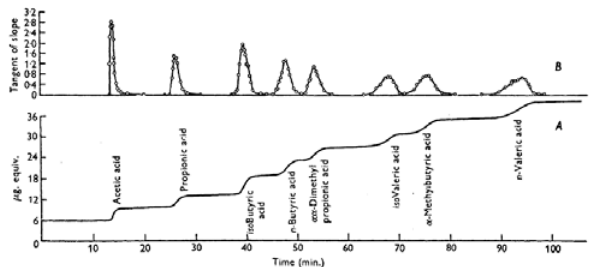
Figure 4. Separation of short-chain carboxylic acids by gas liquid chromatography demonstrated in the seminal paper by James and Martin in 1952 introducing partition gas chromatography. [30] Sep- arations were carried out in a packed column in the isothermal mode. Curve A, experimental results; curve B, derivative of experi- mental curve. For details see Supplementary Information and ref. [30] . From ref. [30] with